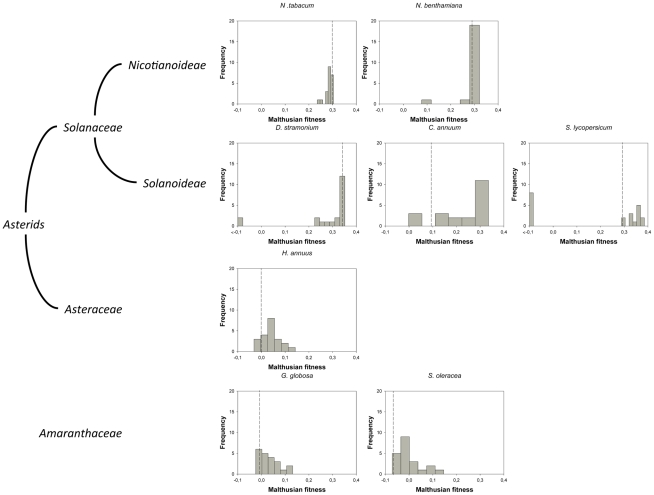
DMFEs across different host species.Host species belong to the taxonomic families Solanaceae, Asteraceae and Amaranthaceae. The first two families belong to the Asterids class. In nature, TEV is found infecting members of the Solanaceae family. The ancestral isolate used in this study was obtained from and subsequently passed in N. tabacum plants. Lethal mutations (which have a Malthusian fitness of −∞) are indicated in the histograms with <−0.1 fitness values. The vertical dashed lines represent the fitness value of the wildtype genotype in each host.